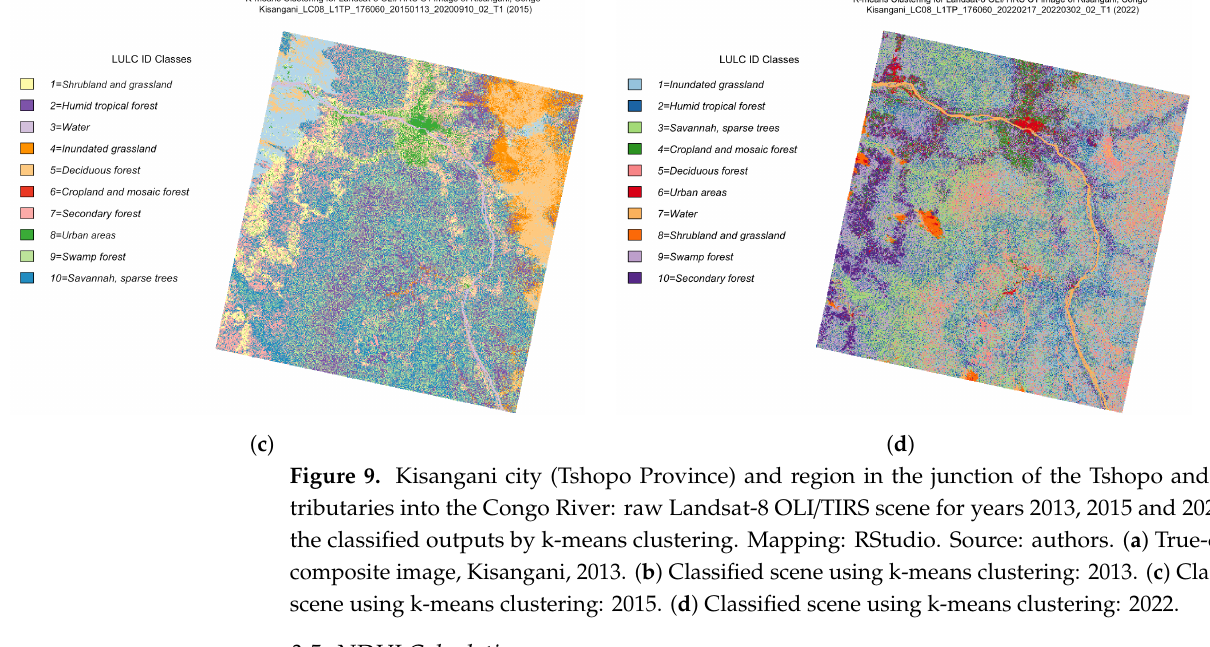
Figure 9. Kisangani city (Tshopo Province) and region in the junction of the Tshopo and Lindi tributaries into the Congo River: raw Landsat-8 OLI / TIRS scene for years 2013, 2015 and 2022 and the classified outputs by k-means clustering. Mapping: RStudio. Source: authors. ( a ) True-colour composite image, Kisangani, 2013. ( b ) Classified scene using k-means clustering: 2013. ( c ) Classified scene using k-means clustering: 2015. ( d ) Classified scene using k-means clustering: